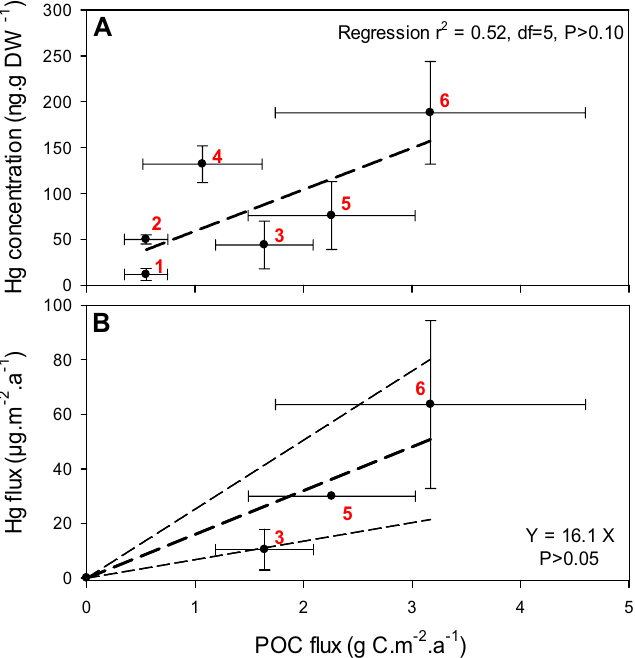
Figure 3. Plots of sediment Hg concentrations ( A ) and fluxes ( B ), and particulate organic carbon (POC) flux in hadal trench and abyssal plain sites world-wide. (Plots show mean ± SD values, for the top few cm of sediment cores or surface sediment grab samples. Study locations and Hg data sources in panel ( A ): 1—Marianna/ Yap Trenches 18 , 2—Marianna Trench 19 , 3—Kermadec Trench and abyssal plain (this study), 4—New Britain Trench 19 , 5—Kuril-Kamchatka Trench and abyssal plain 16 , 6—Atacama Trench and abyssal plain and slope (this study). In panel ( B ), the locations and sources for data points 3 and 6 are the same as in panel A, but for point 5 the flux is from one core on the Kuril Basin abyssal plain 17 . Linear regression equations are shown as dashed lines, and in ( B ) the regression was forced through the origin. POC flux data are from Longhurst 26 as tabulated by Stewart and Jamieson 24 and Jamieson 35